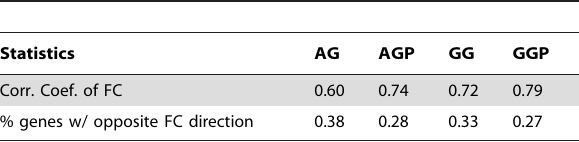
Table 3. Consistency of fold changes between redundant probe set